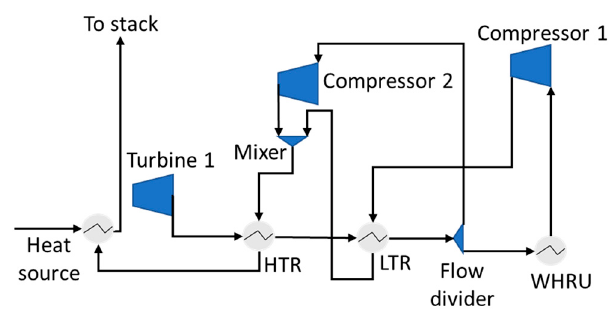
Figure 3. S − CO 2 recompression Brayton cycle [52]. Figure 3. S-CO 2 recompression Brayton cycle